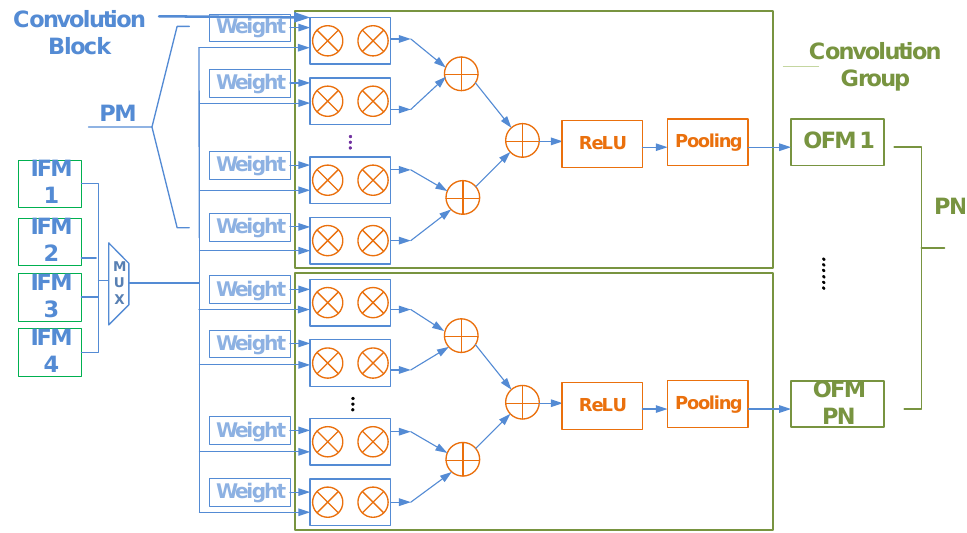
Figure 4. The computational architecture of a convolution layer.